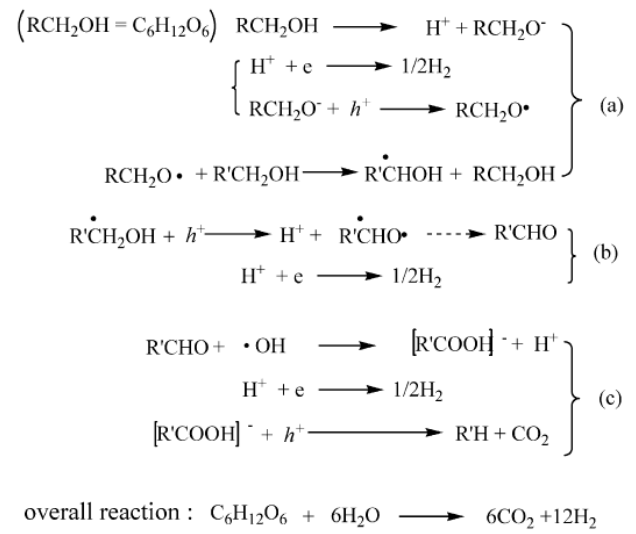
Figure 6. Pathways of glucose in photocatalytic reforming (Adapted from Ref. [85]). Table 1. Summary of photocatalytic reforming of biomass for hydrogen evolution.